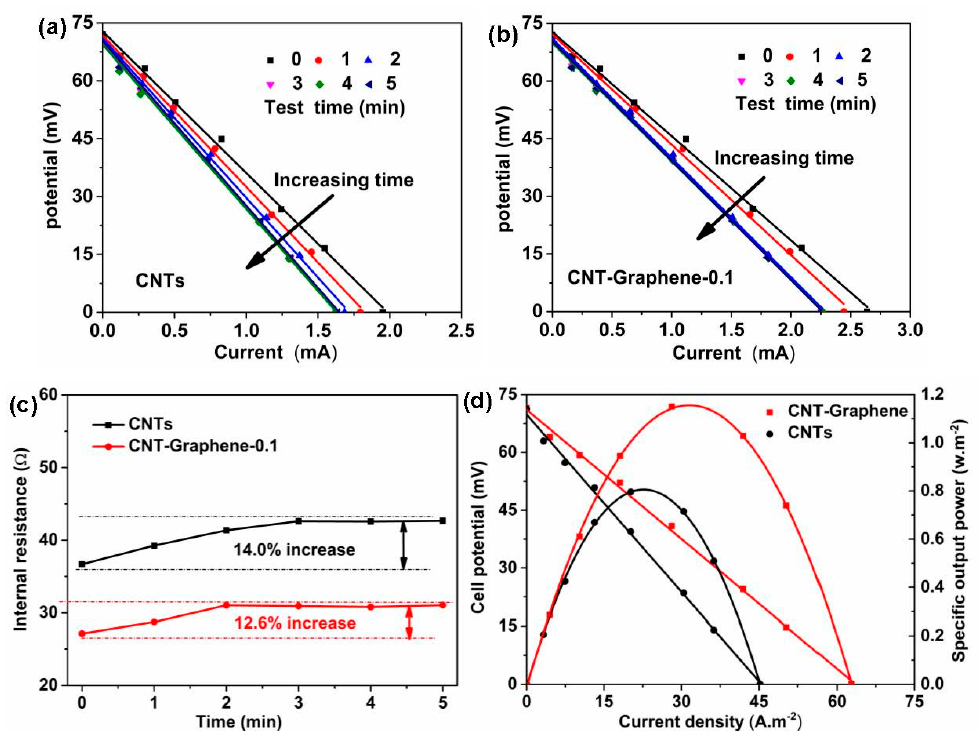
Figure 6. ( a ) Cell potential versus current for ( a ) CNT and ( b ) CNT-Graphene-0.1 electrodes, ( c ) fitting curve of internal resistance versus test time, and ( d ) plots of cell potential and specific output power versus current density at the steady state.